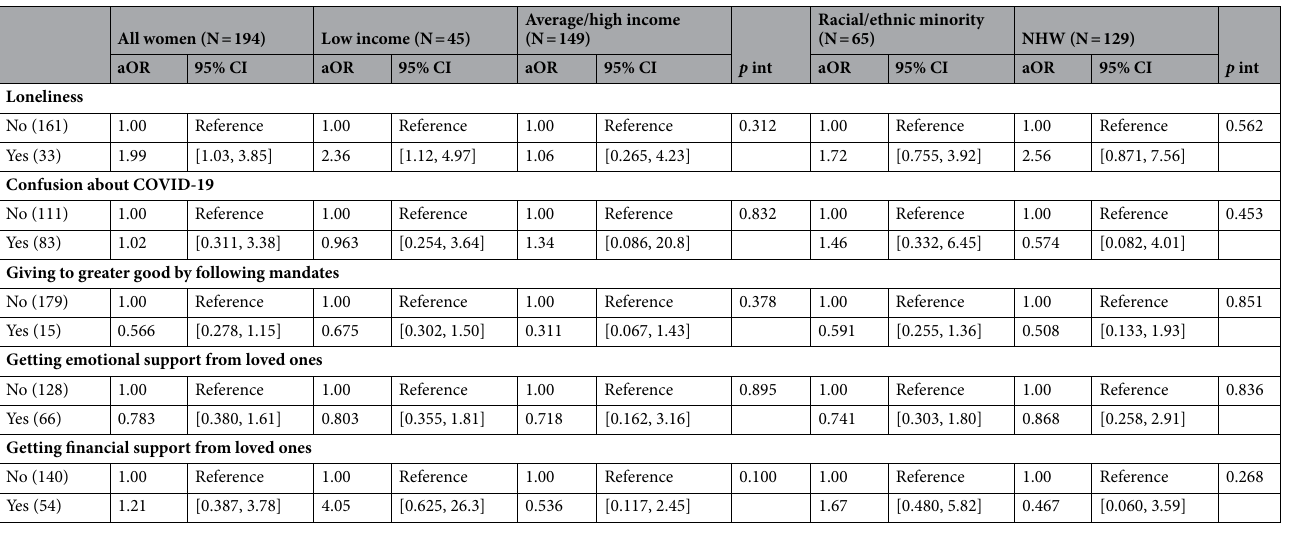
Table 3. Adjusted odds ratios (OR, aOR) and 95% confidence intervals (CI) for the association between COVID-19 experiences and odds of more depressive symptoms among BRCA1/2 -positive women from disadvantaged health populations, overall and by income status and race/ethnicity. Missing values: change in life due to COVID-19 (15), age (3), and cancer status (3). Bold font indicates statistically significant with corresponding p < 0.02. p interaction terms are between income status and predictor(s). Covariates/ stratifications: age (continuous), number of comorbid conditions (continuous), years since genetic